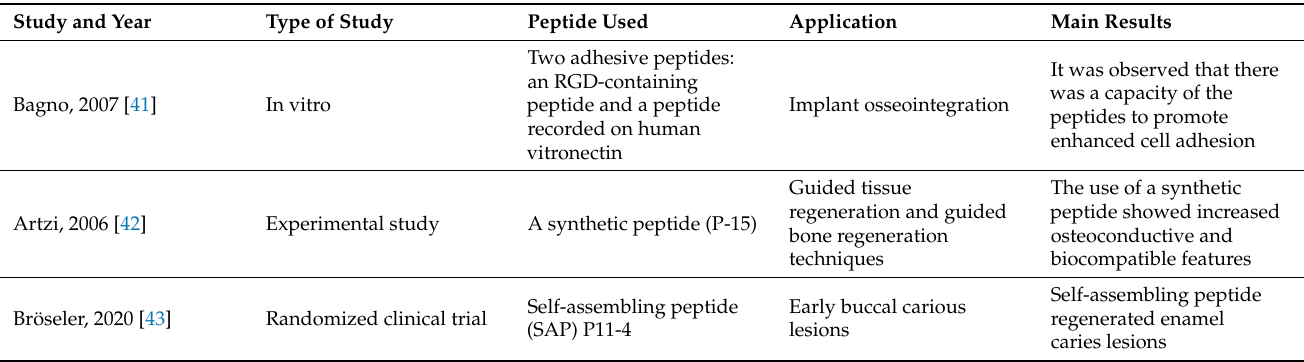
Table 2. Characteristics of the included